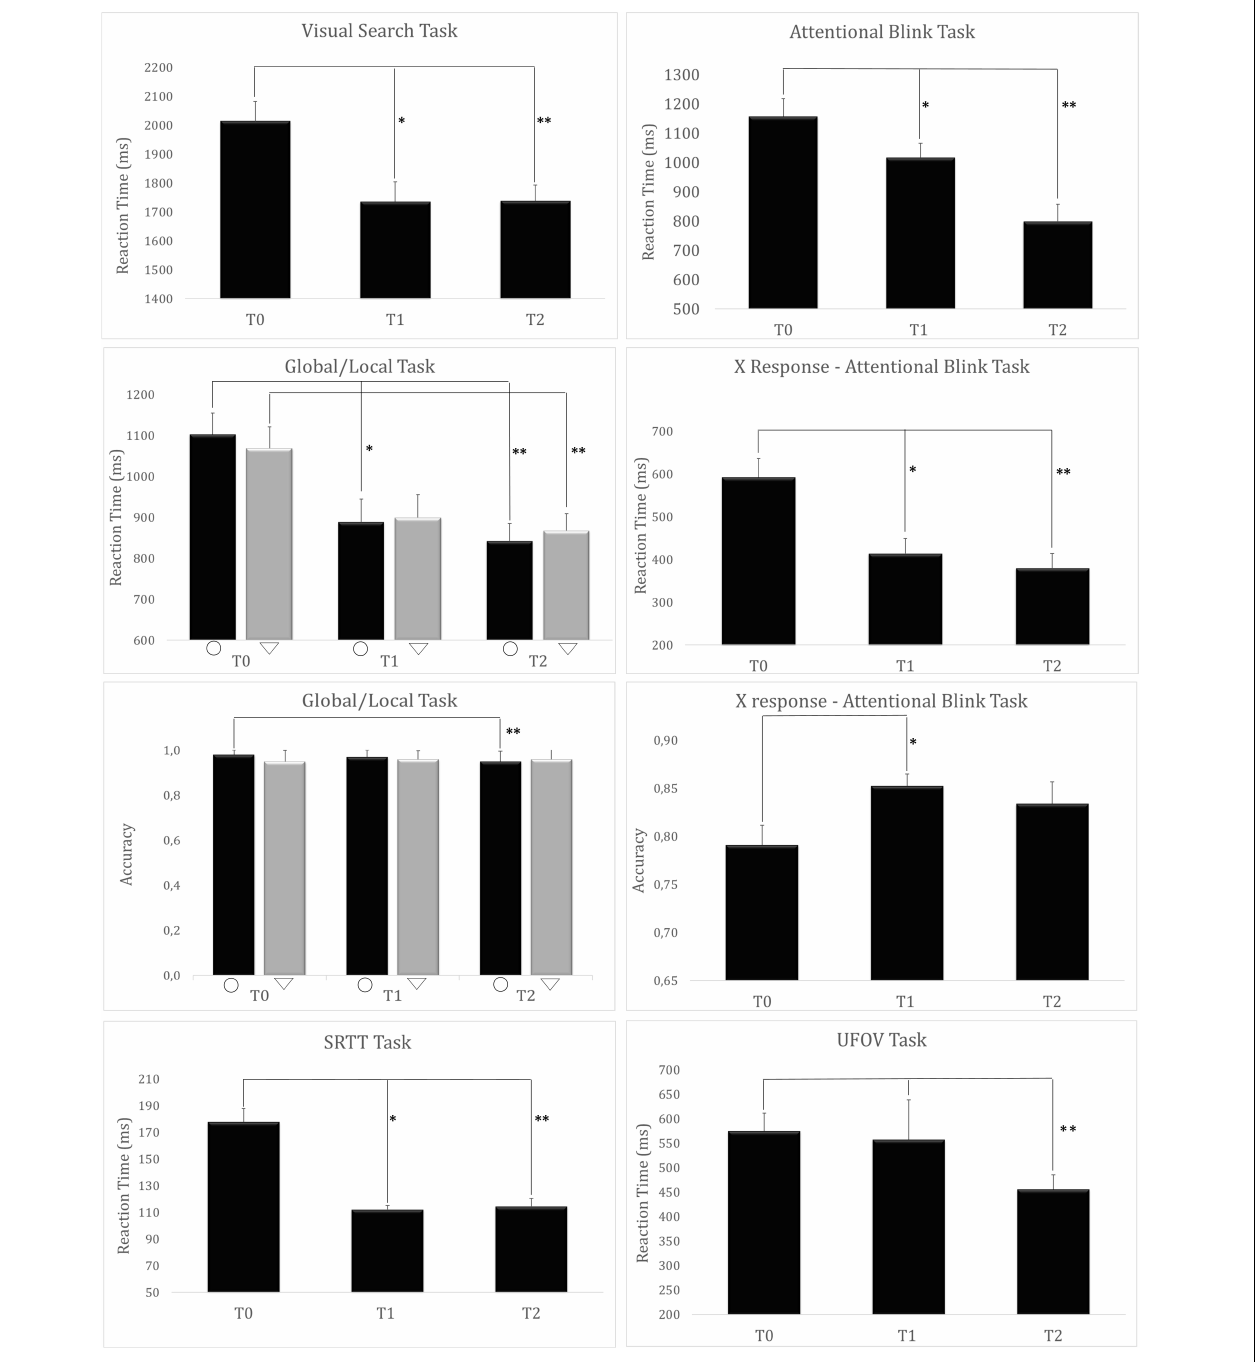
FIGURE 4 | Long Term Cognitive Transfer results. Graphical depictions of the significant effects observed between cognitive assessments ( ∗ significant difference between T1 and T0; ∗∗ significant difference between T2 and T0; Global/Local Task: ∇ : Global Features (cid:13) : Local Features).